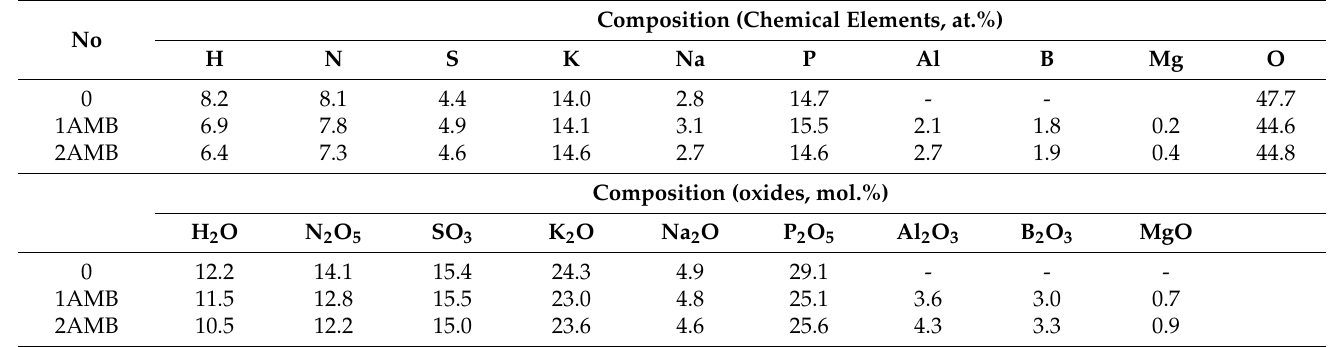
Table 3. Chemical composition of various glass–matrix composites produced (combined data of ICP and EDS